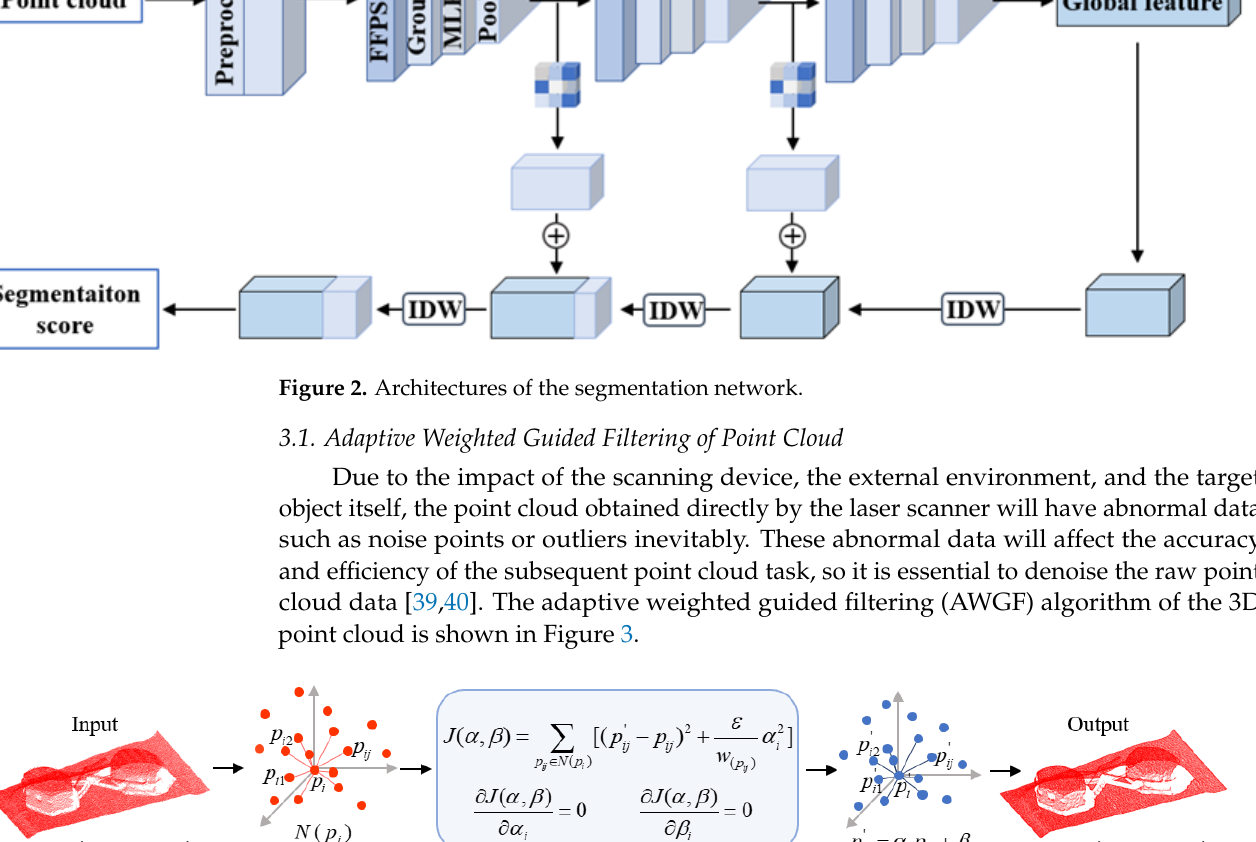
Figure 3. The pipeline of the AWGF.